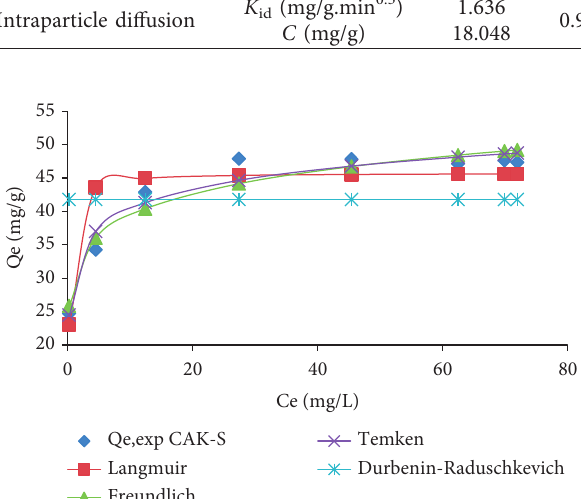
Figure 7: Nonlinear plot of two-parameter adsorption isotherm models of HQ by CAK-S.